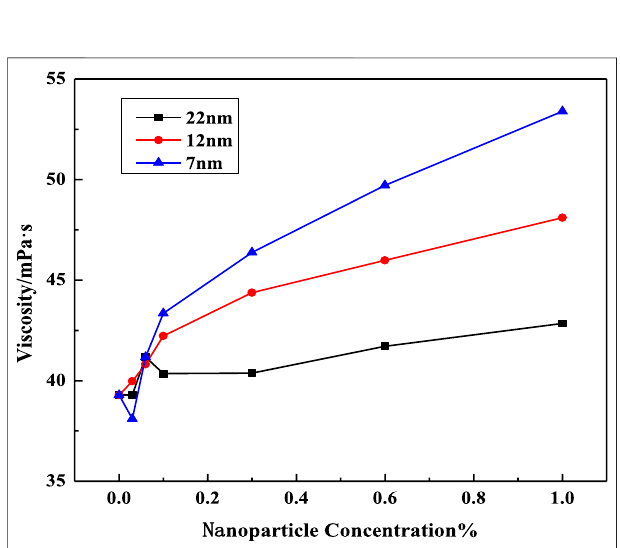
FIGURE 4 | Effect ofSiO 2 concentration on solution viscosity at different nanoparticle diameters ( w (LBA + SDS) (cid:2) 0.8%, LBA:SDS (cid:2) 3:1, T (cid:2) 50 ° C, w (NaCl) (cid:2) 2%, γ (cid:2) 7.34s − 1